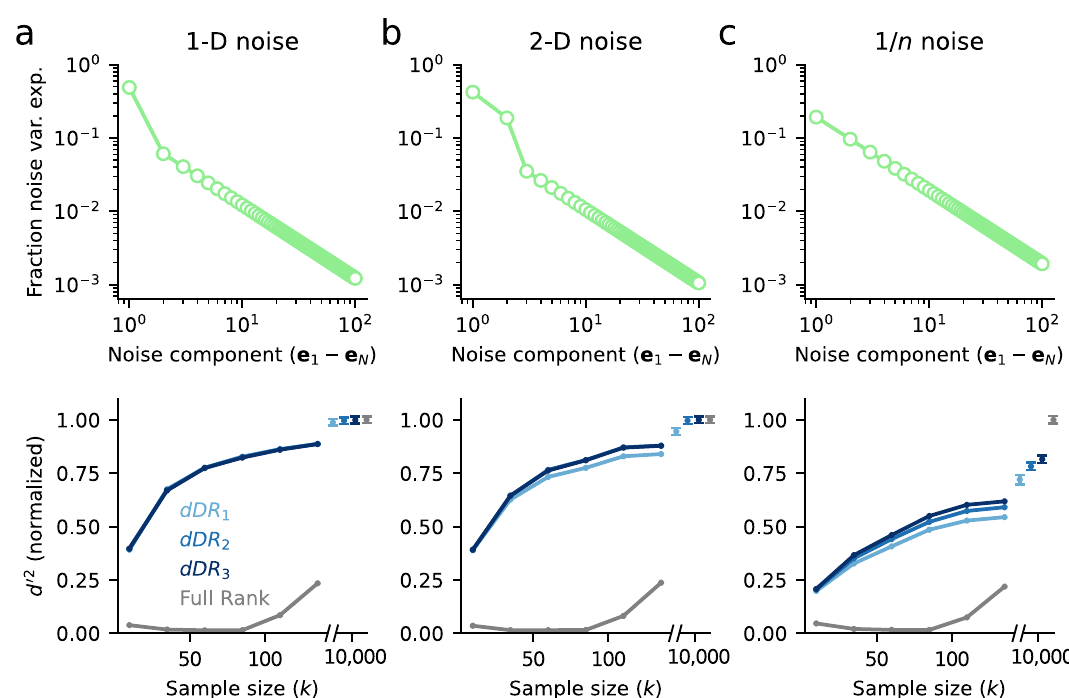
Fig 5. Evaluation of decoding accuracy and reliability with dDR . a . Analysis of data with one-dimensional (1-D) noise covariance. For each sample size, k , 100 datasets were generated from the same multivariate Gaussian distribution (Eq 4) where S was a rank-one covariance matrix and the mean response vector, μ , corresponded to one of two stimulus conditions, a or b . Top: Scree plot of noise covariance. Bottom: Cross-validated discriminability, d 0 2 , between a and b computed with full-rank data and with dDR using one ( dDR 1 ), two ( dDR 2 ) or three ( dDR 3 ) noise dimensions, as a function of sample size. Mean d 0 2 across all 100 surrogate datasets is shown here. For k > > N , the dDR results converge to the asymptotic value of the full-rank d 0 2 . However, even for small k , the dDR analyses estimates are much more accurate than the full-rank approach. b . Same as in (a), but for two-dimensional noise covariance data. In this case, dDR 2 captures the second noise dimension and outperforms the standard 1-D approach ( dDR 1 ) c . Same as in (a) and (b), but for 1/ n noise